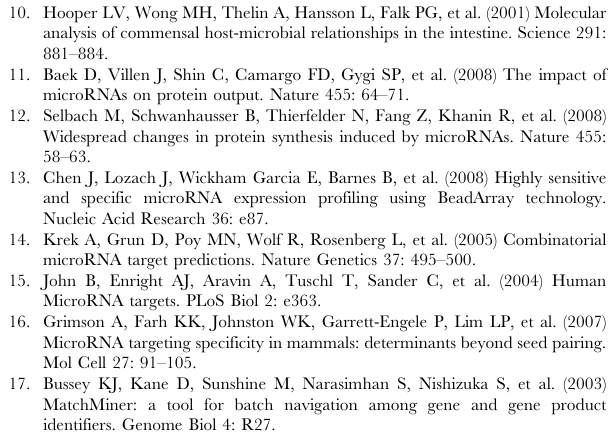
Table S7 DNA microarray-detected dysregulated genes that were potentially targeted by miRNAs differently expressed in the ileum upon colonization. Table S8 DNA microarray-detected dysregulated genes that were potentially targeted by miRNAs differently expressed in the colon upon